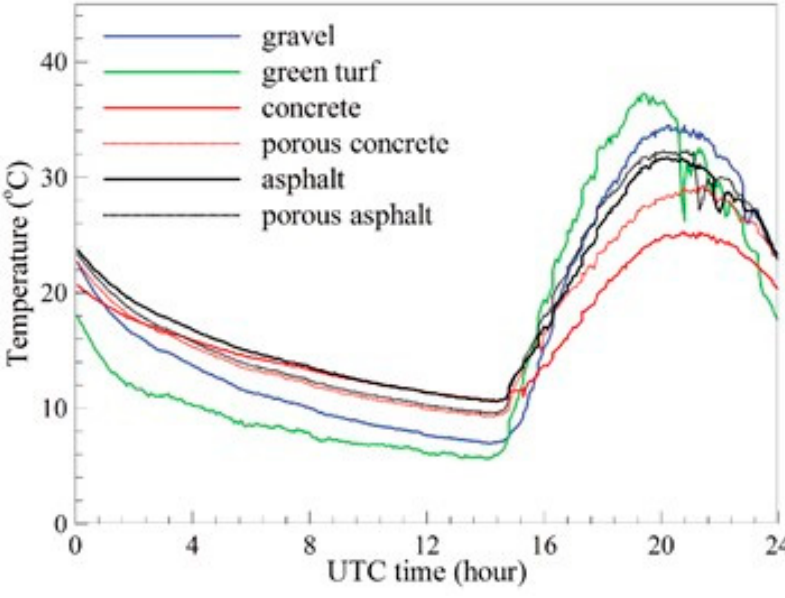
Figure 5. Surface temperature of six types of ground cover materials [96].